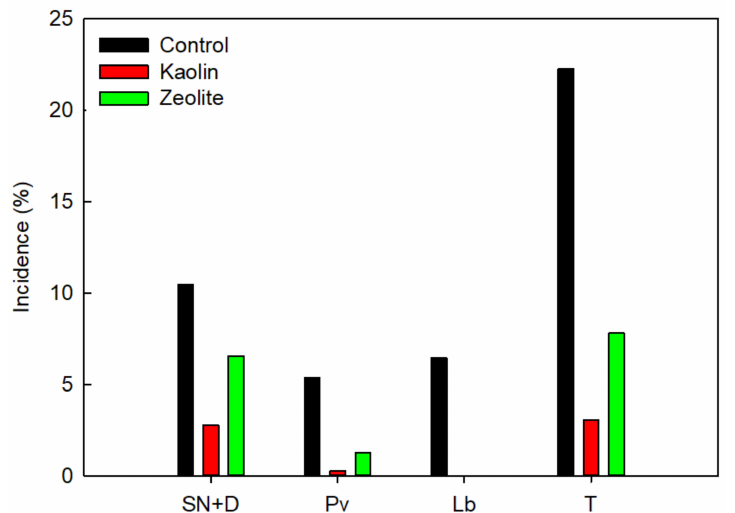
Figure 2. Incidence (%) of sunburn necrosis and dehydration (SN+D), Plasmopara viticola (PV) and Lobesia botrana (Lb) pests of control, kaolin, and zeolite vines at harvest 2018. T: the total amount of clusters affected by both abiotic and biotic